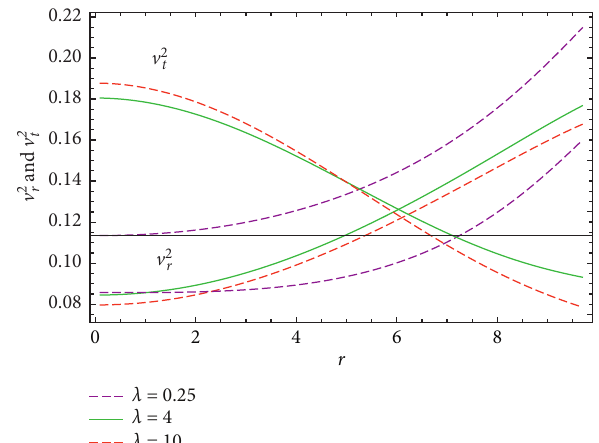
Figure 11: Graphical analysis of v 2 Vela X-1.